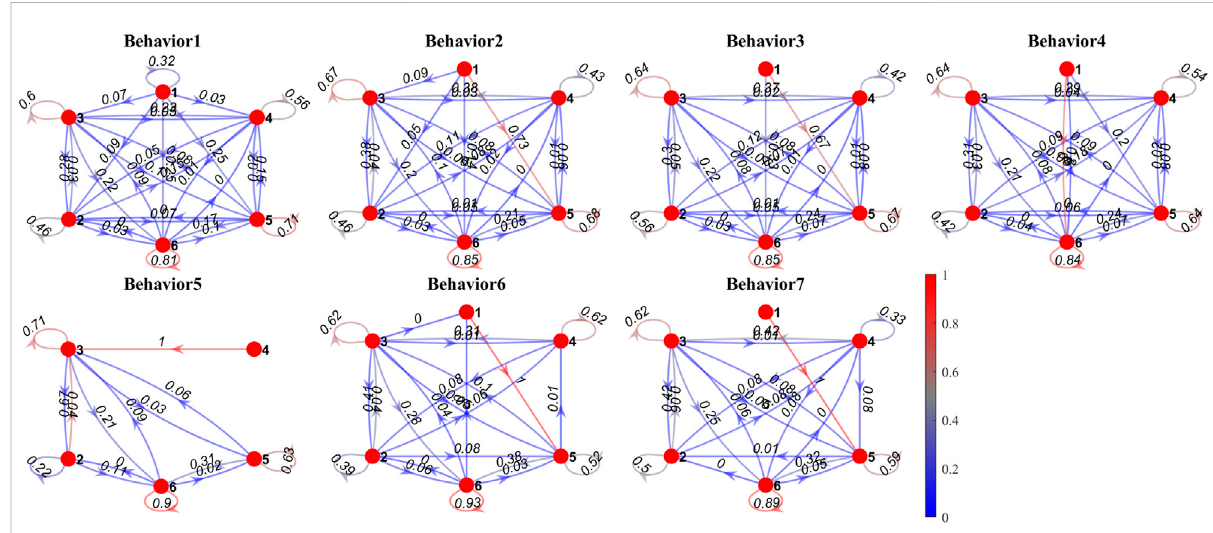
FIGURE 10 Markov chains of interaction state transfer in typical behaviors. The red dots indicate interaction states from S 1 to S 6 . The color of the arrows indicates the probabilities of state transfer.